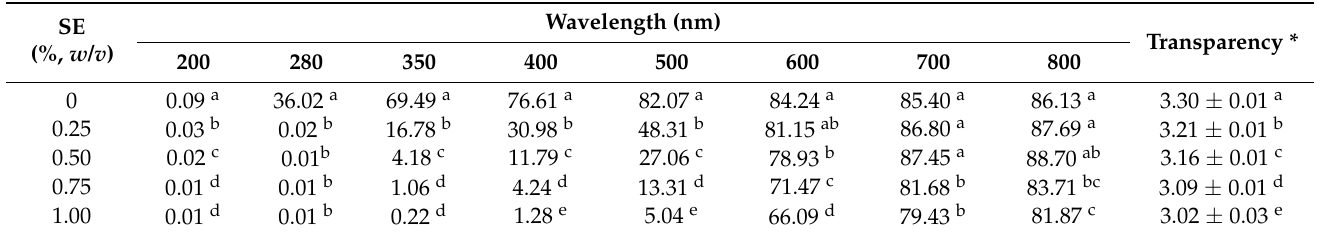
Table 3. Light transmission and transparency of gelatin films incorporated with sappan heartwood extract (SE) at different